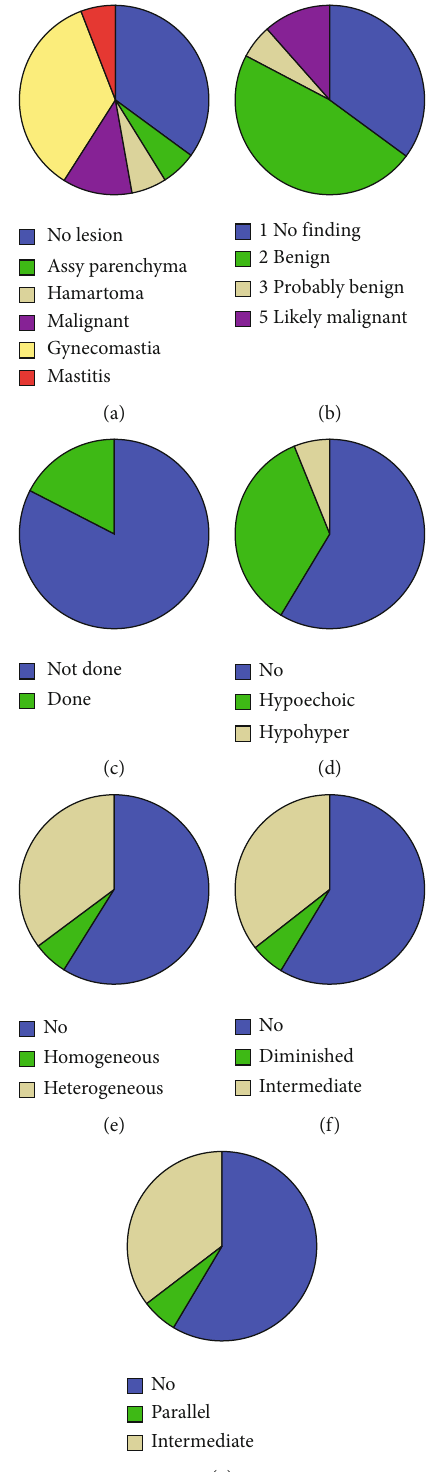
Figure 2: Characteristics of breast lesions found on mammography and ultrasound characteristics of breast lesions: (a) details of image diagnosis, (b) distribution of BI-RADS category, (c) biopsy status, (d) appearance of the lesion, (e) internal echoes, (f) acoustic transmission, and (g) axis of the